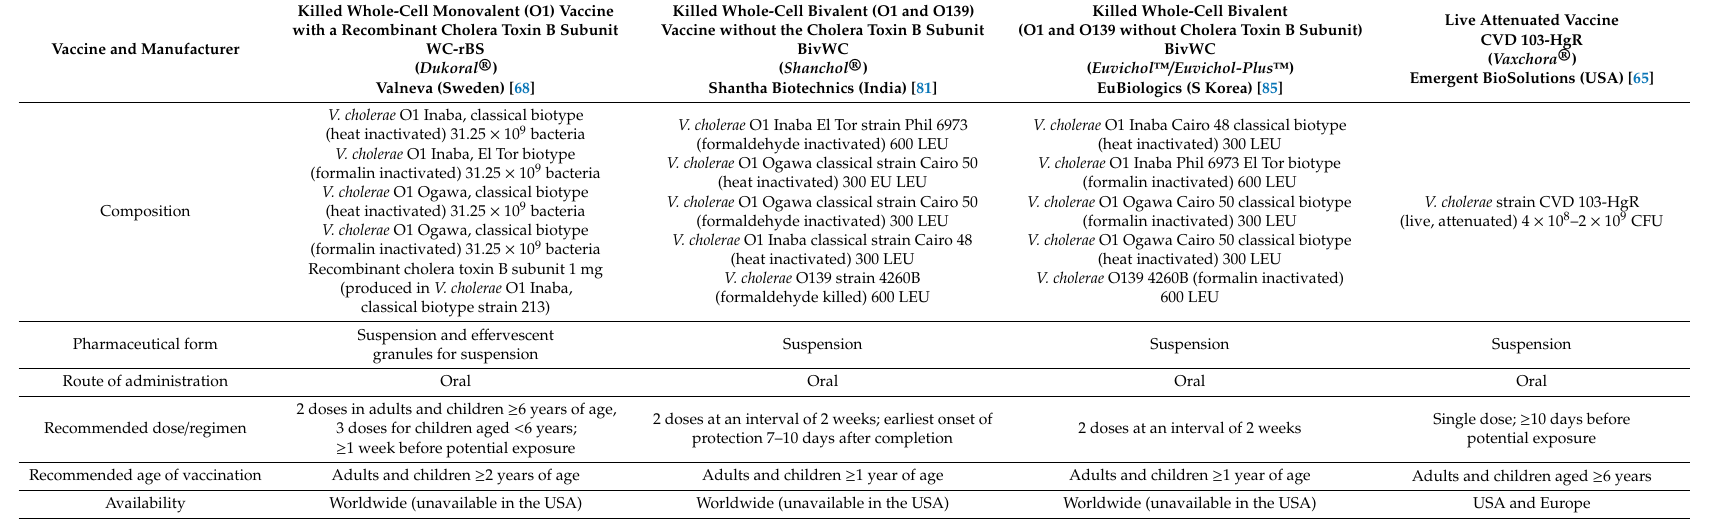
Table 2. Summary of currently available cholera